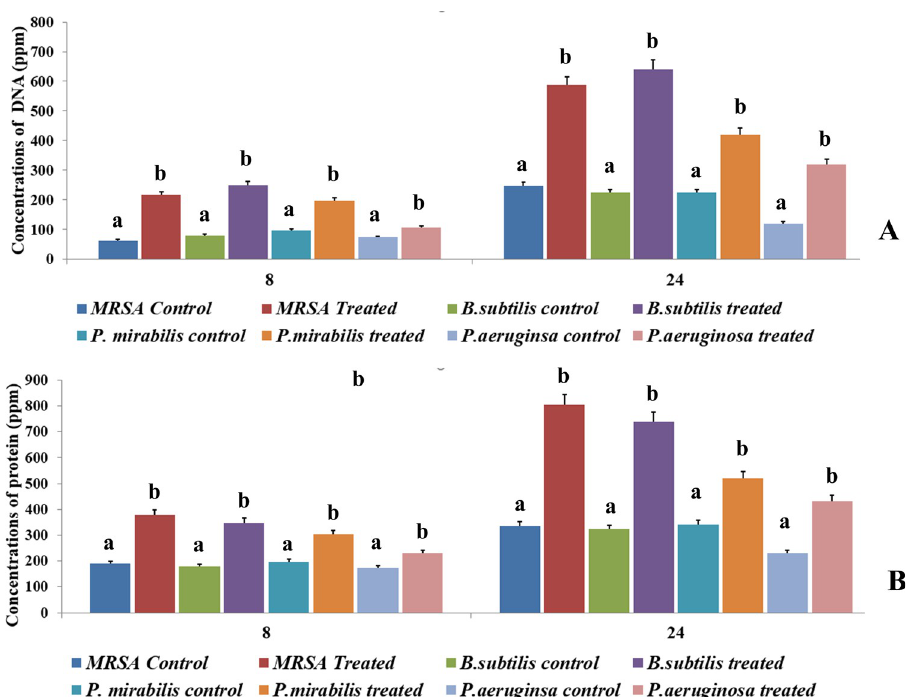
Fig 4. Leakage of intracellular macromolecules in to extracellular environment A–DNA content B- protein content. Values on the graphs are the means ± Standard error (SE) of the three replicates. Tukey’s multiple comparison test was performed. The different letters a, and b in each case (for each bacterial pathogen at control and at treated condition) represents a significant difference between them (At, P < 0.05).